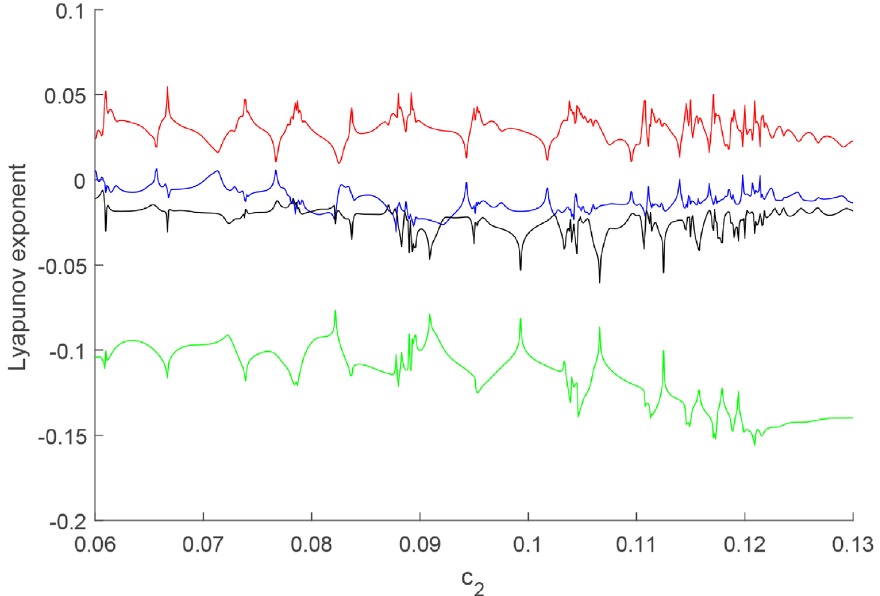
Fig 2. Lyapunov exponent